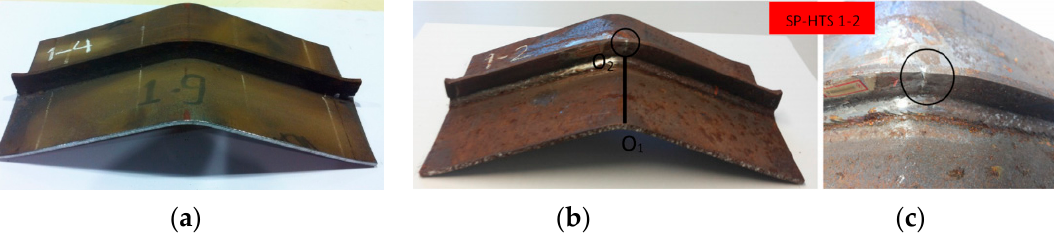
Figure 3. Axial load-shortening displacement ( a ) mid-lateral displacement ( b ) and local strain ( c ) for intact stiffened plate SP-NS1-4.